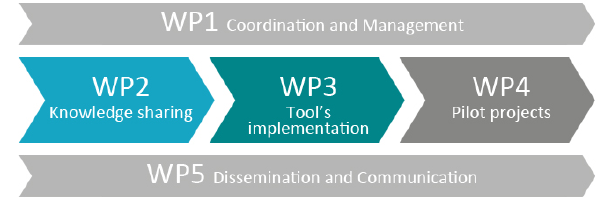
Figure 2: Schematic overview of MESP Work